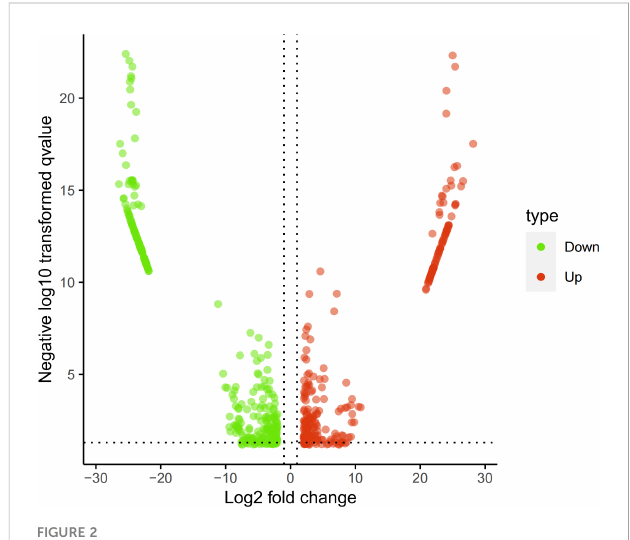
FIGURE 2 Volcano map of mRNA sequencing results. Red: up-regulated differential genes; Green: down-regulated differential